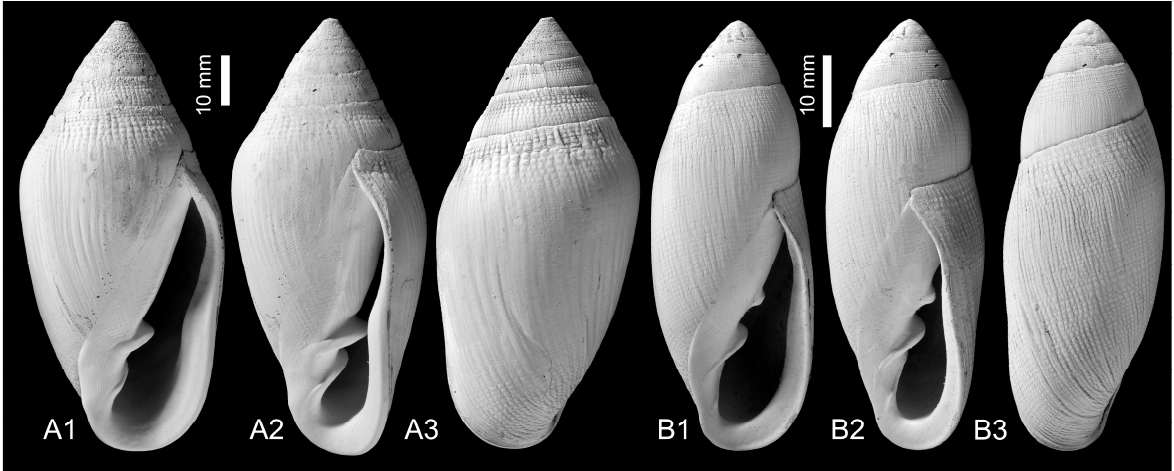
Figure 1. Recent Ellobium species: ( A1 – A3 ) Ellobium aurismidae NHMW-MO-83901/G/19, Moluccas; ( A1 ) apertural view, ( A2 ) oblique apertural view, ( A3 ) dorsal view; ( B1 – B3 ) Ellobium aurisjudae NHMW-MO-75000/E/9194, New Guinea, ( B1 ) apertural view, ( B2 ) oblique apertural view, ( B3 ) dorsal view.